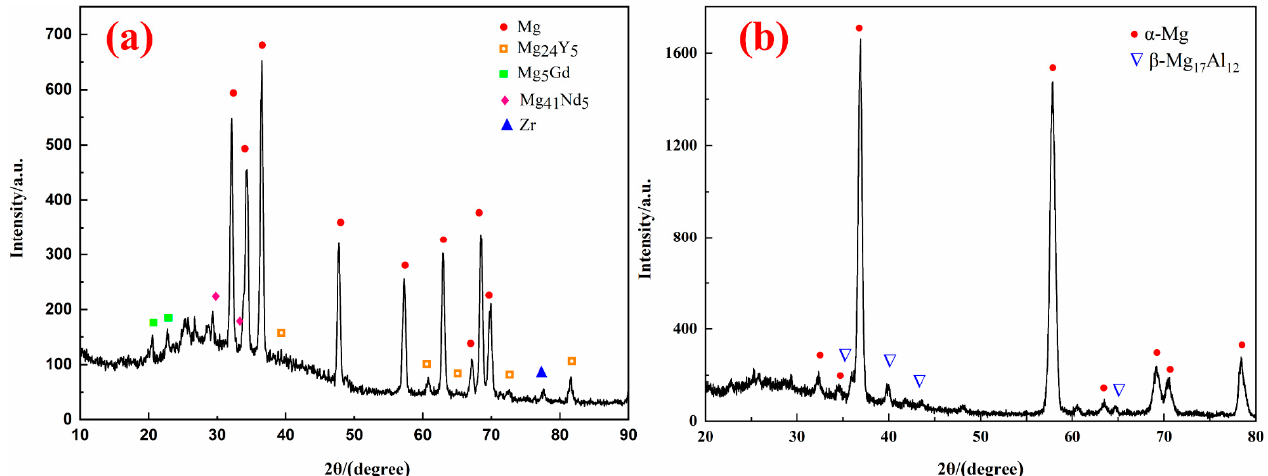
Figure 1. The XRD pattern of ( a ) WE43 and ( b )